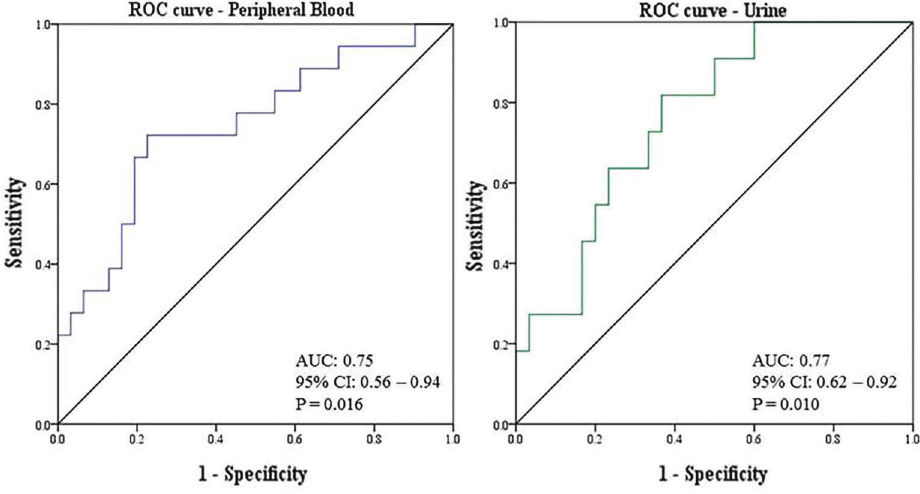
Figure 2. Receiver operating characteristic curves (ROC) of miR-142-3p expressions in the peripheral blood and urine of renal transplanted recipients. AUC: area under the curve; CI: con fi dence interval.